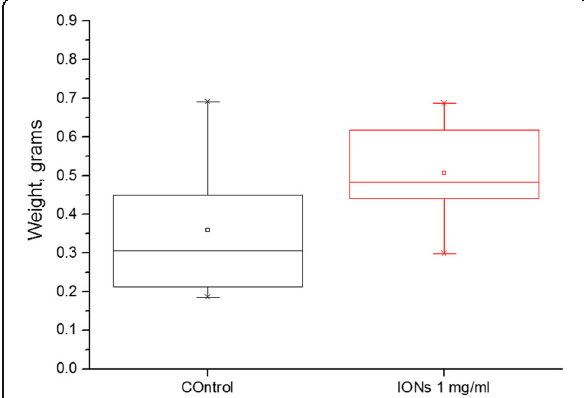
Fig. 3 Fresh weight of plants, measured after 5 days of